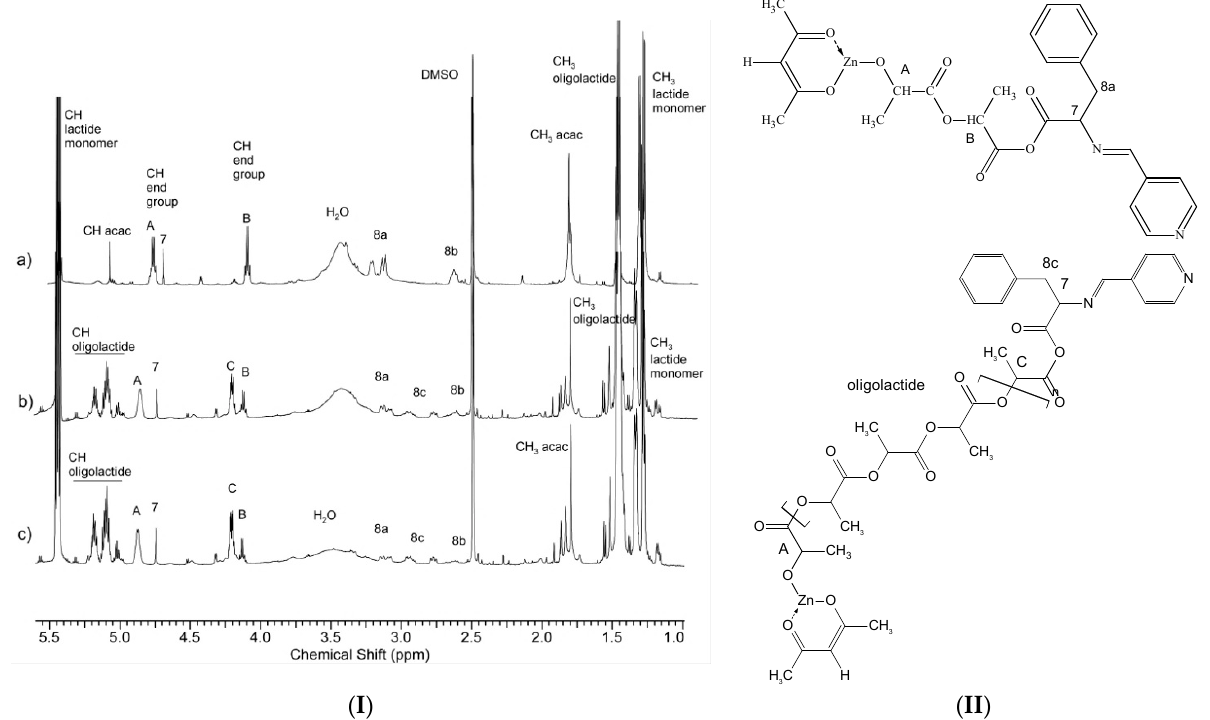
Figure 9. ( I ) 1 H NMR spectra of the product of the L -lactide polymerization conducted in benzene with Zn[(acac)(Lphe)]xH 2 O as an initiator with an I/M ratio of 1:12: after 20 min ( a ), 1.5 h ( b ), and 9 h ( c ). ( II ) Hypothetical chemically dominated structure of the products of L -lactide polymerization with use of Zn[(acac)(Lphe)H 2 O] as the initiator: after 20 min. ( a,b ).